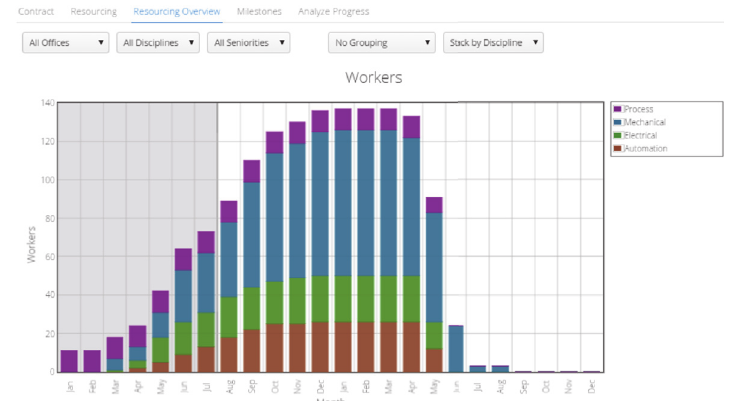
Figure 12: Resourcing overview.